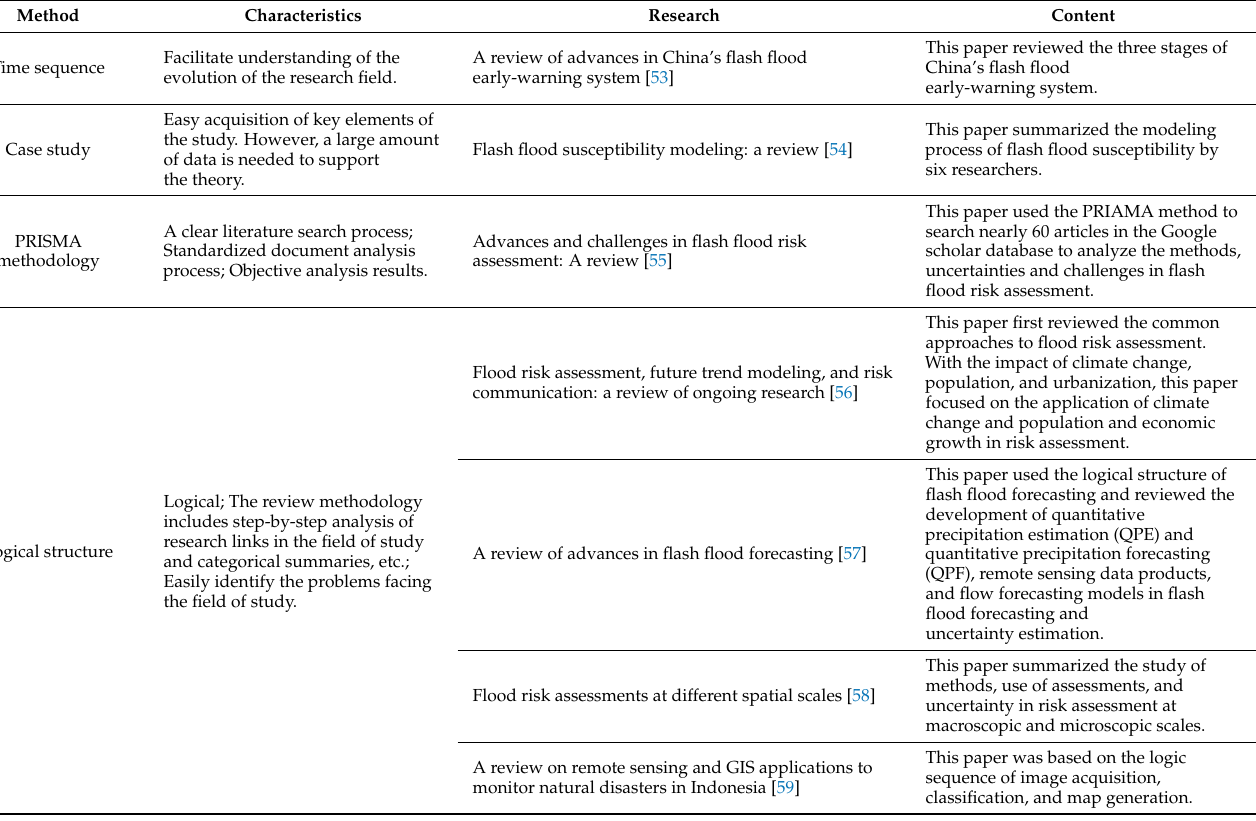
Table 1. Summary of previous